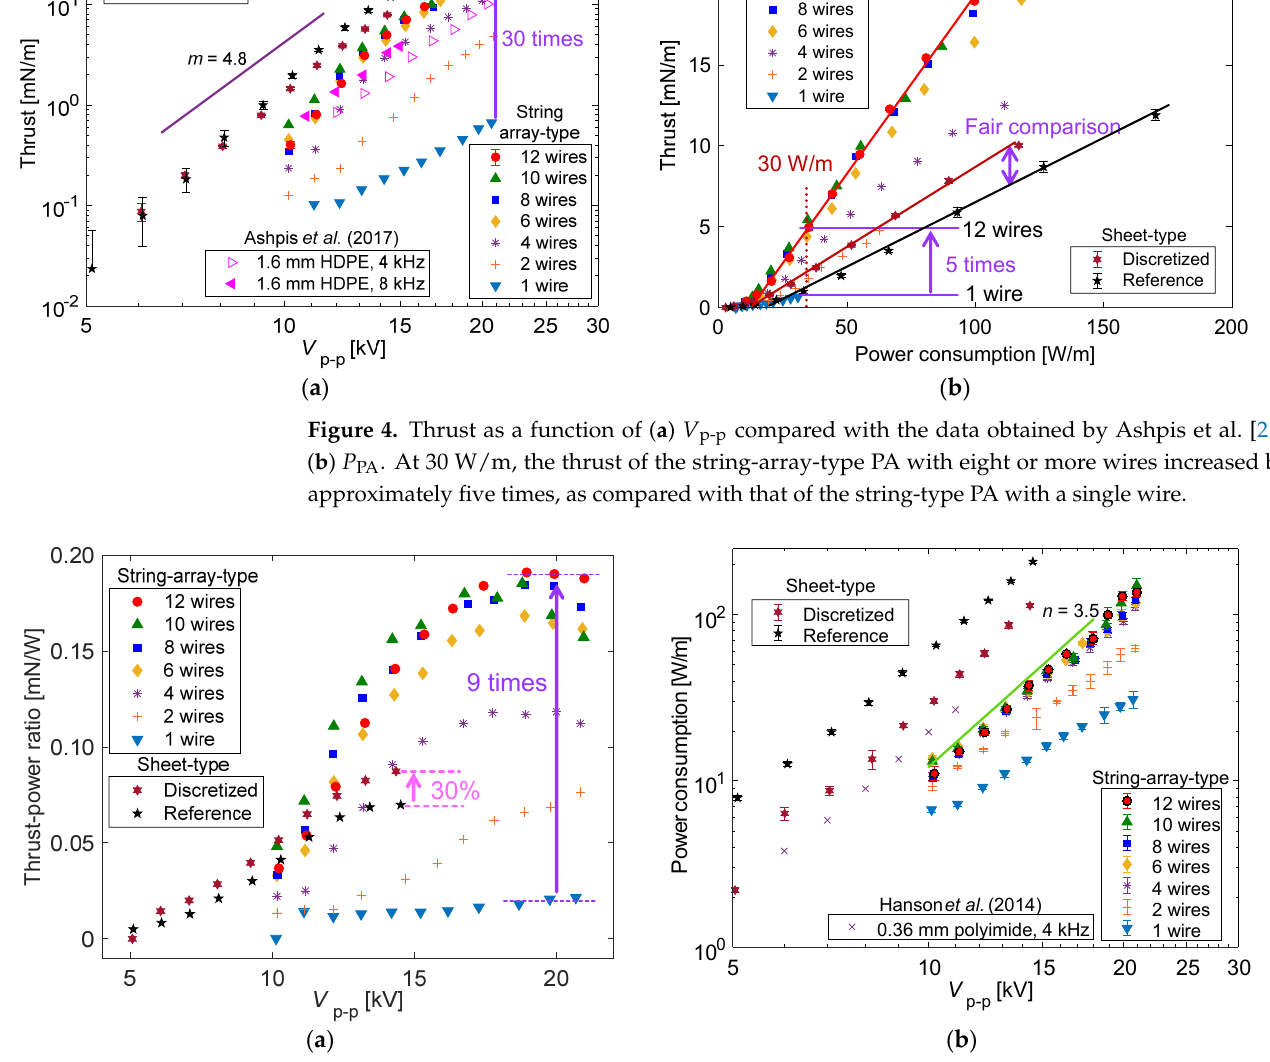
Figure 5. ( a ) V p-p as a function of the thrust–power ratio. The thrust–power ratio increased by 9 times for eight or more wires, compared with that when using a single wire, in the case of V p-p ≥ 18 kV; it also increased by 30% by the discretized PA as a direct comparison with the reference PA at V p-p = 14 kV; ( b ) Power consumption as a function of V p-p in comparison with the data obtained by Hanson et al. [22].